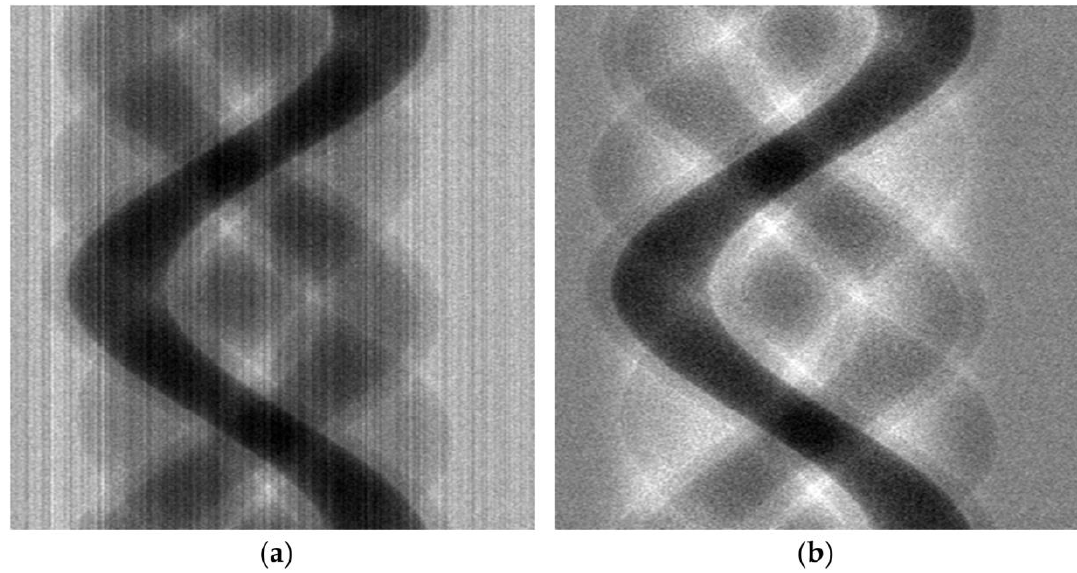
Figure 3. An example of mis-calibrated pixel correction in the sinogram acquired with a PCXD. ( a ) Before the correction. ( b ) After the semi-correction.